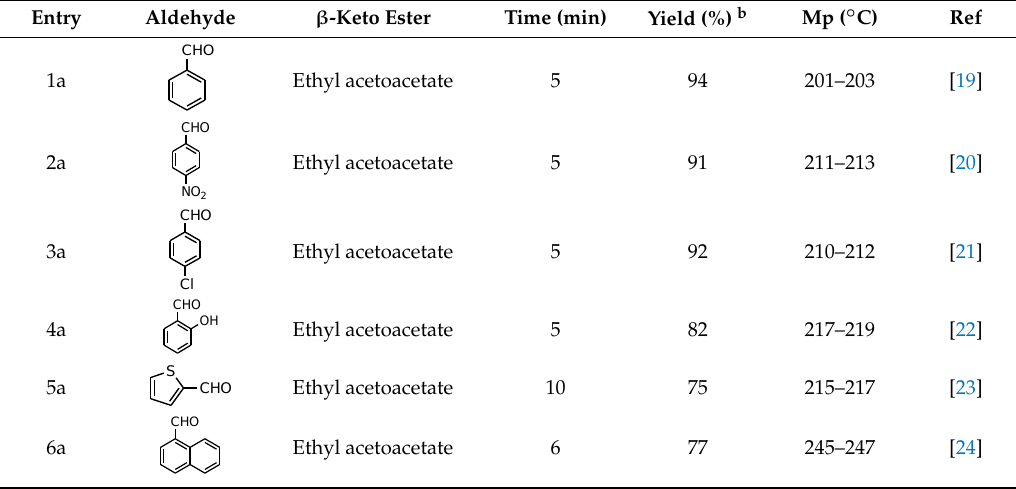
Table 2. Synthesis of dihydropyrimidinones catalyzed by Cu@SBA-15 under solvent free conditions a . Entry